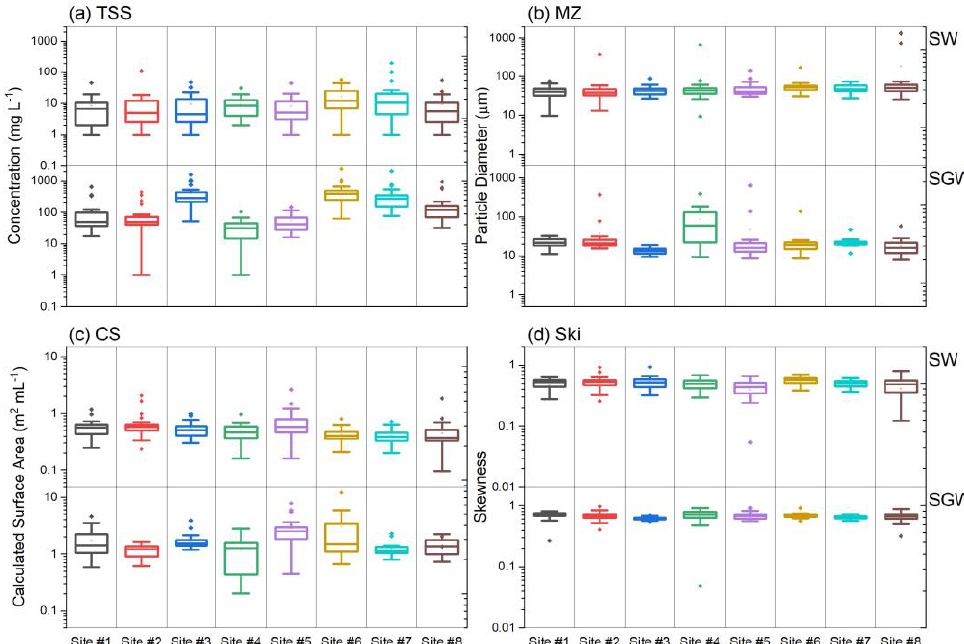
Figure 3. Box and whisker plots of stream water (SW) and shallow groundwater (SGW) suspended sediment characteristics [i.e., total suspended solids; TSS (mg L − 1 ), mean particle size; MZ (µm), calculated surface area; CS (m 2 mL − 1 ), and skewness; Ski] during the study period (January 2020 − December 2021) for eight monitoring sites in Moore’s Run Watershed, Wardensville, WV, USA; box delineates 25th and 75th percentiles; line denotes median; open circle shows mean; whiskers delineate the range (i.e., 1.5 times the interquartile range); the filled circle indicates potential outliers.